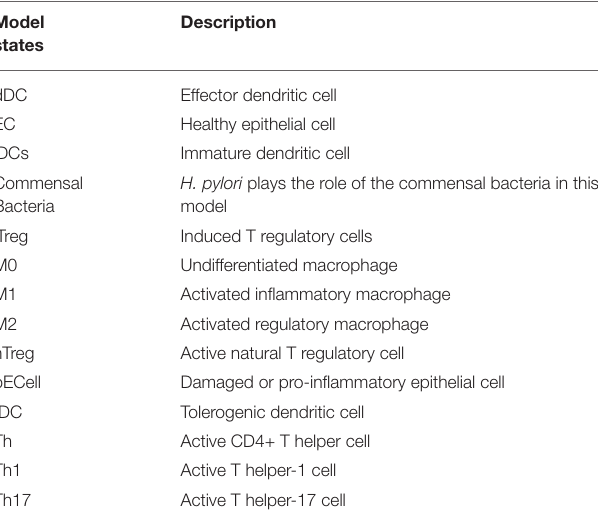
TABLE 1 | Model states and their respective description (adapted from ([1, 49, 50]). Model states